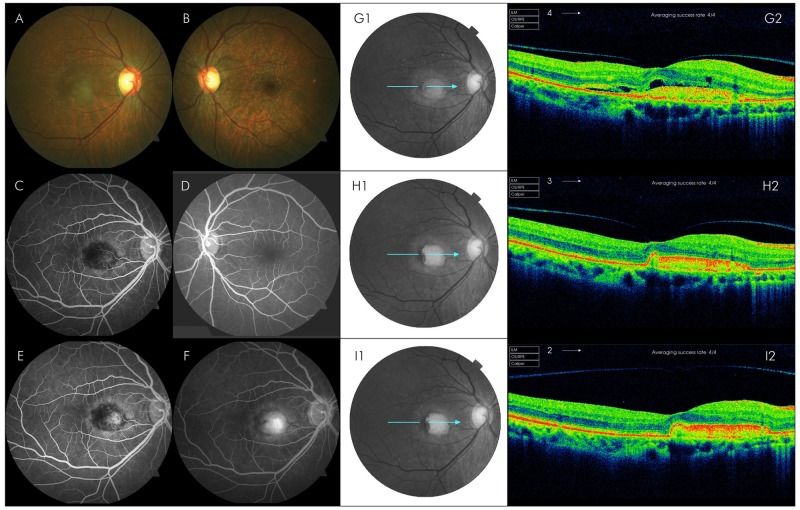
Fundus photograph (CFP), fluorescein angiogram (FFA) and spectral domain optical coherence tomography (SD-OCT) of a 56-year female presenting with metamorphosia in the right eye of 2 months’ duration.CFP (A and B) shows drusen and reticular pseudodrusen (RPD) in both eyes with subfoveal CNV in the right eye confirmed with FFA (C-F). SD-OCT showed vitreomacular adhesion (VMA), intraretinal (IRF) and subretinal fluid (IRF) and retinal pigment epithelial detachment (PED) at baseline(G), with resolution of IRF and SRF at 4 (H) and 12 (weeks) and separation of the VMA at 12 weeks (I). Visual acuity at baseline of 0.4 LogMAR improved to 0.24 LogMAR and 0.2 LogMAR at 4 and 12 weeks, respectively.